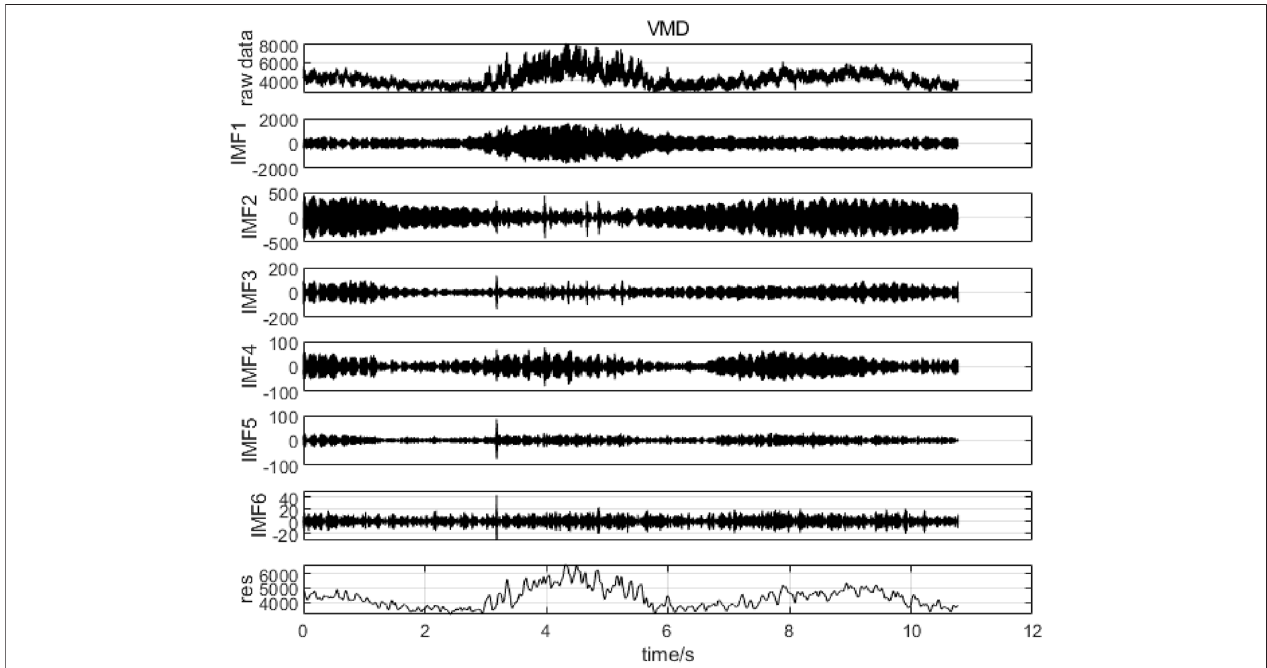
FIGURE 3 | VMD decomposition results for original time series of power load.